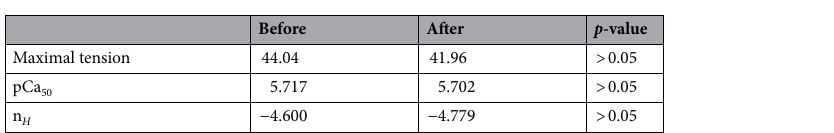
Table 1. Comparisons of maximal tension, pCa 50, and Hill’s coefficient (n H ) in detergent-extracted (skinned) fibers before and after receiving β-CTX (n = 9).